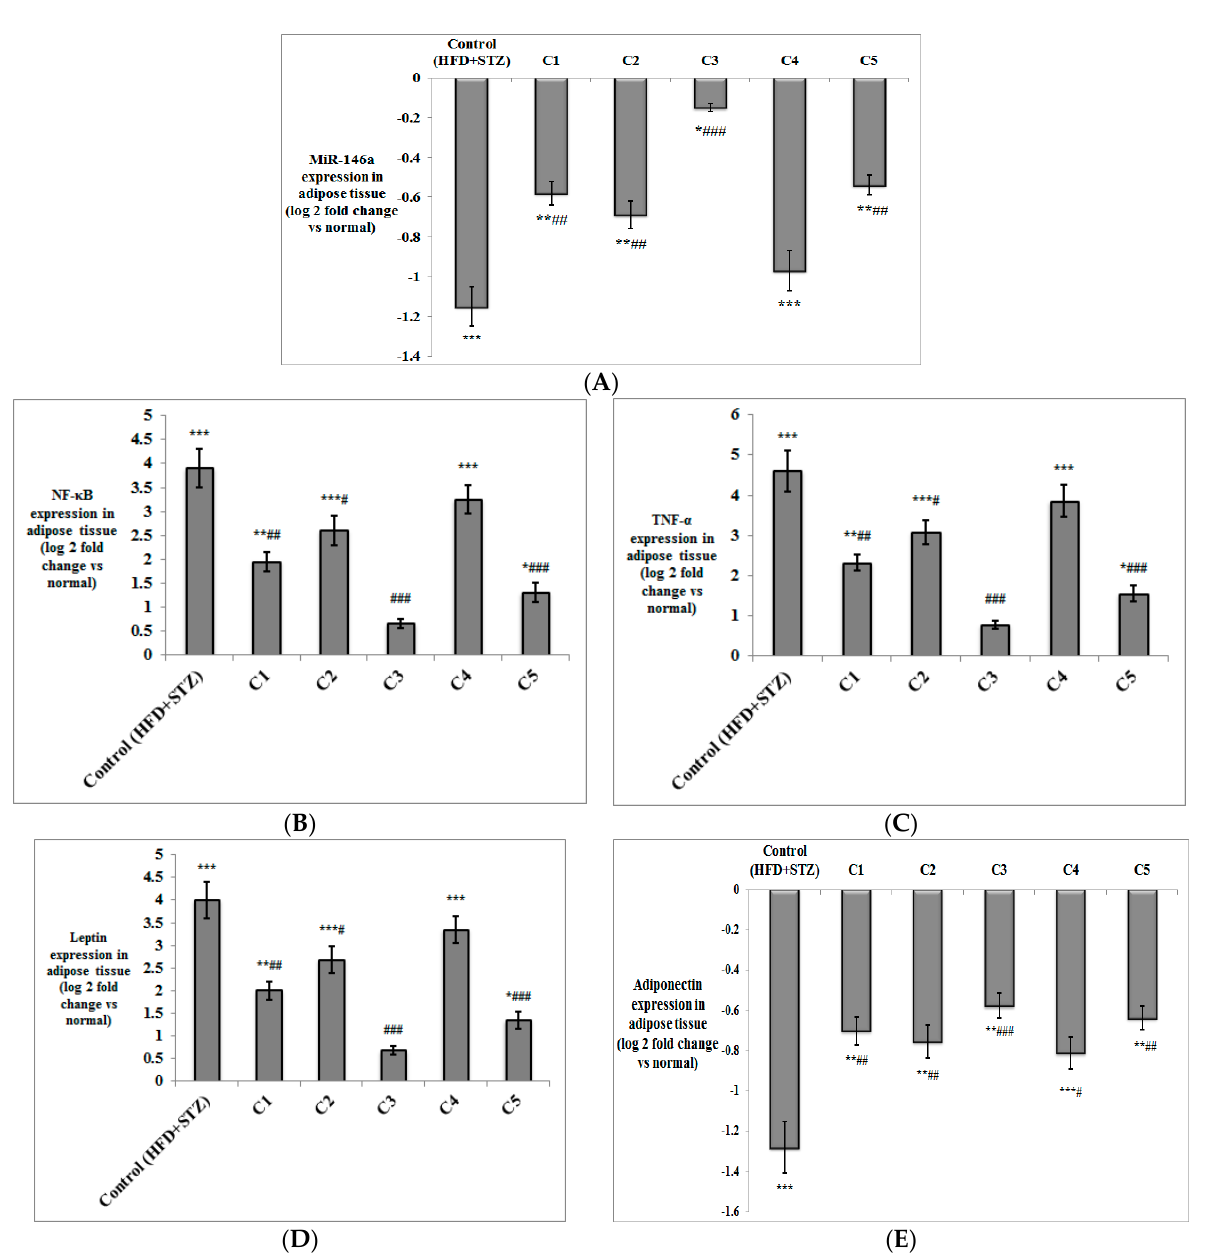
Figure 3. The effect of the isolated compounds on the expression of ( A ) miR-146a, ( B ) NF- κ B, ( C ) TNF- α ( D ) leptin, and ( E ) adiponectin in the adipose tissue of the experimental rats. ( n = 6–8). NF- κ B = nuclear factor kappa B; TNF- α = tumor necrosis factor-alpha. C1: Rutin; C2: Quercetin 3- O -neohesperdoside; C3: Quercetin-3- O - β -galactoside; C4: Isoquercetin; C5: Quercetin. Data are expressed as mean ± SD of the log 2-fold change relative to the normal group (log 2 (1) = zero, i.e., base line). Statistical significance in relation to the normal group was assigned at * p < 0.05; ** p < 0.01; and *** p < 0.001; whereas statistical significance in relation to the T2DM control group (high fat diet + Streptozotocin) was assigned at # p < 0.05; ## p < 0.01; and ### p < 0.001 using one-way ANOVA, followed by Bonferroni’s post hoc test.